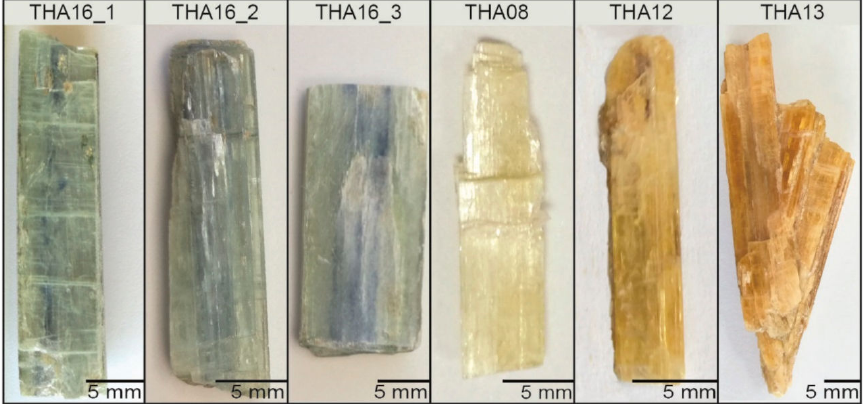
Figure 8. Photographs of individual kyanite crystals prior to bulk rock analyses.